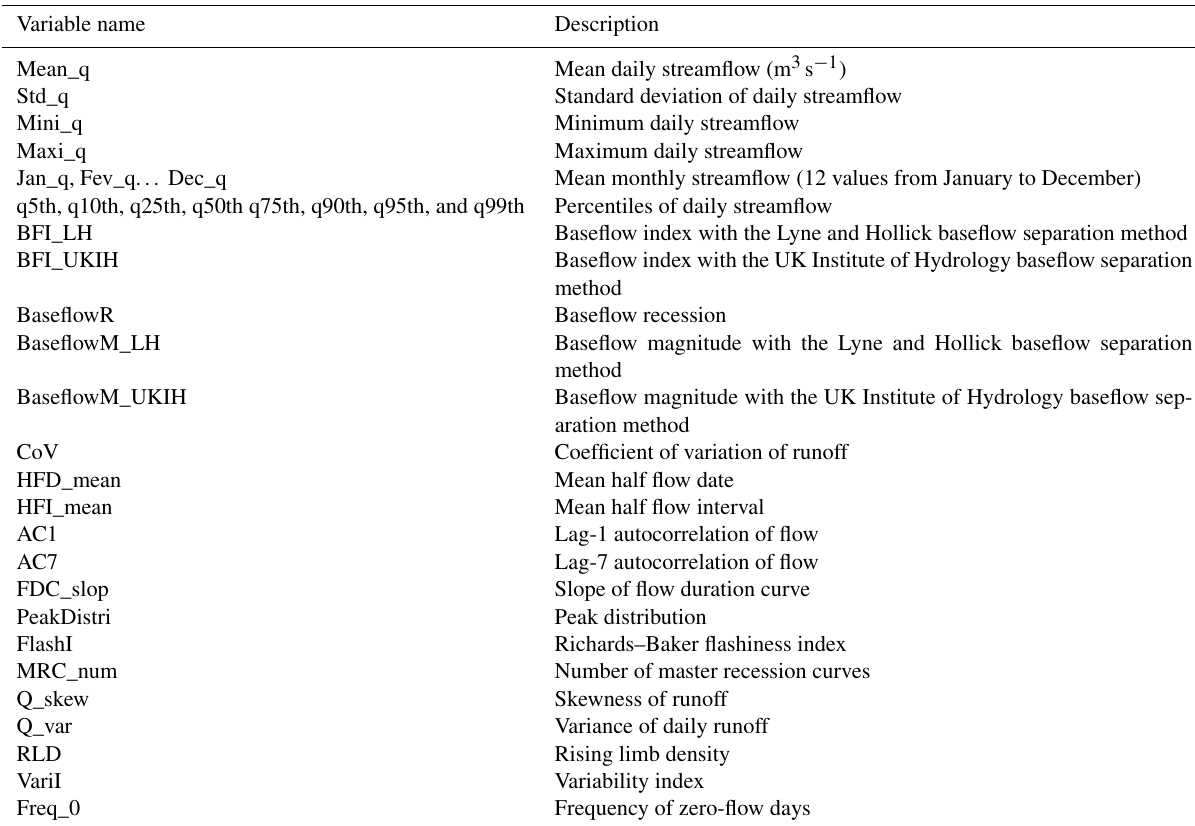
Table 3. Hydrometric indices in the file